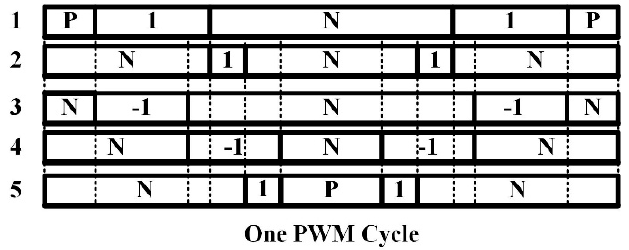
Figure 3. The action order of the five-phase impulse current duties in one PWM cycle.